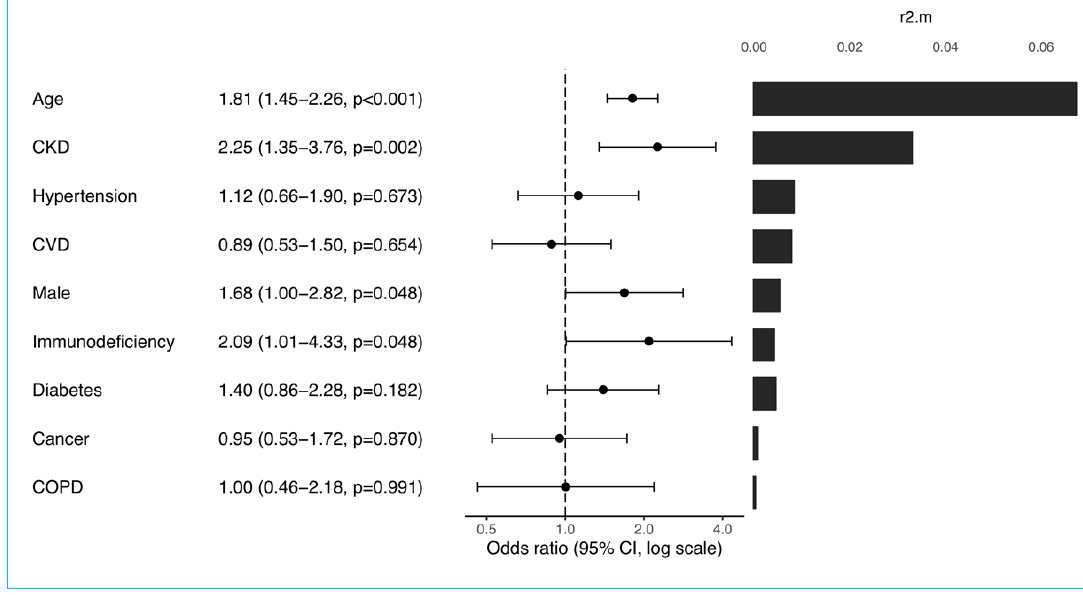
(percentage) or median (interquartile range [IQR]).